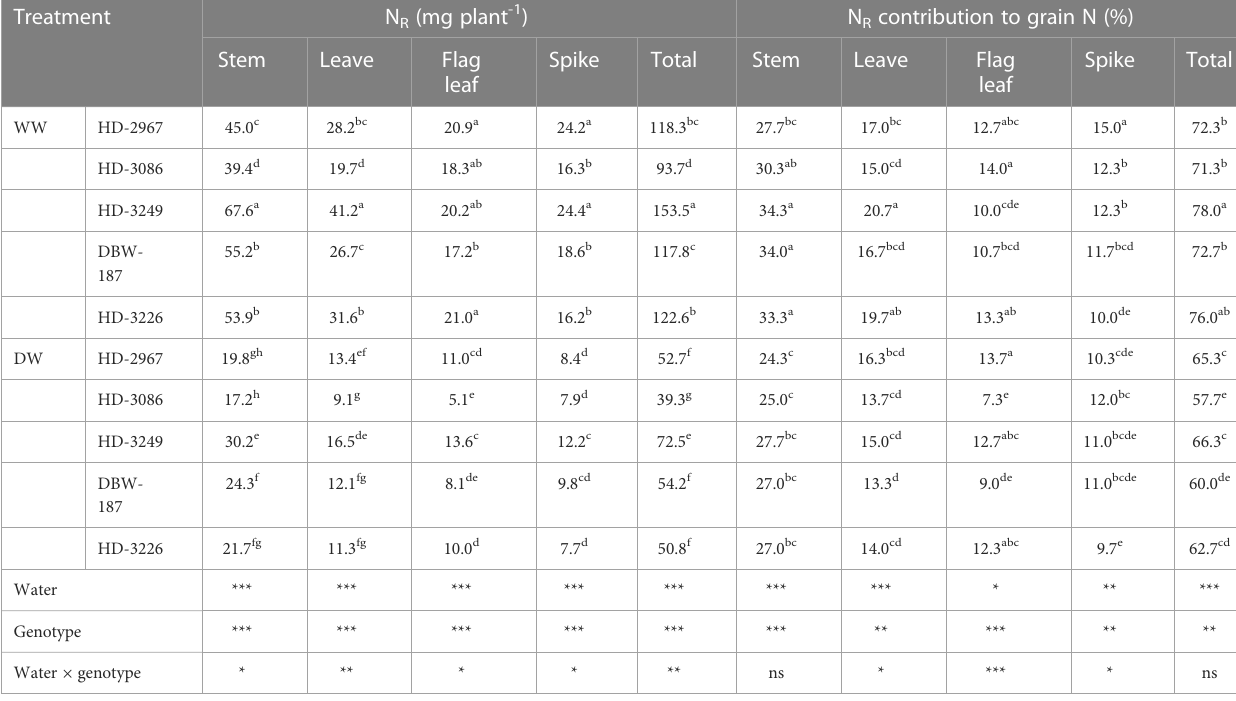
TABLE 5 Nitrogen remobilisation and contribution to grain nitrogen of the vegetative organs of wheat genotypes grown under well- and de fi cit- watered conditions. Treatment N R (mg plant -1 ) N R contribution to grain N